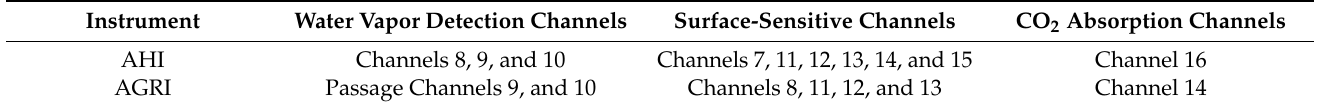
Table 2. Similar functional channels between the AHI and